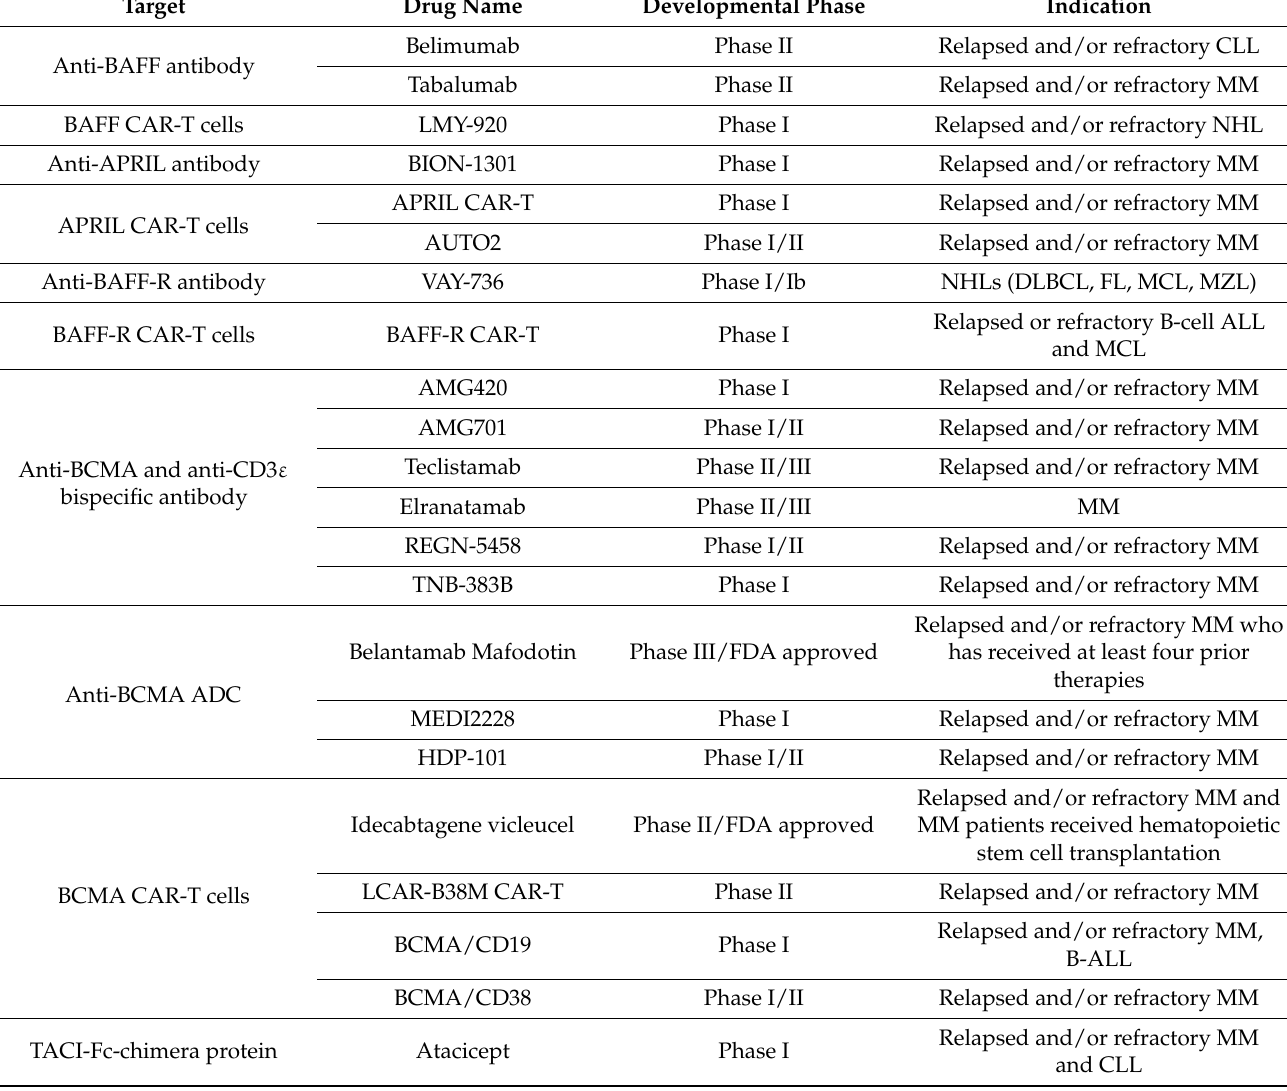
Table 3. Drugs targeting the BAFF-APRIL